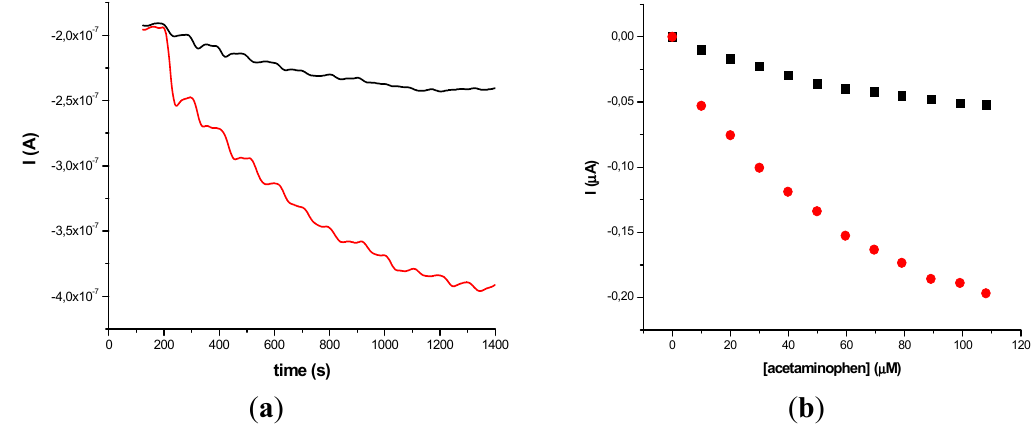
GCE ( Φ 1 mm) modified with HRP/SWCNT/PEI film; (HRP concentration: 0.3 mg·mL − 1 (black) and 0.6 mg·mL − 1 in PEI 1 mg·mL − 1 (red)), after the addition of constant volumes (5 µL) of 10 − 2 M acetaminophen solution in PBS (pH 7.4; 0.1 M) in the presence of 0.2 mM H O . 2 2